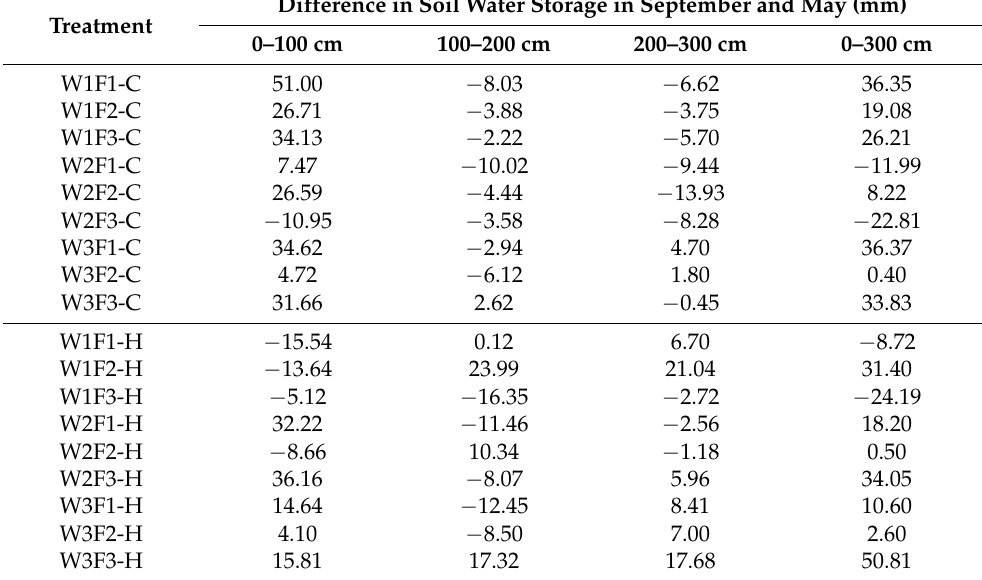
Table 3. Differences in soil water storage between May and September at 0–300 cm soil layer under each treatment (C and H refer to Calligonum mongolicum and Haloxylon ammodendron , respectively). Difference in Soil Water Storage in September and May Treatment